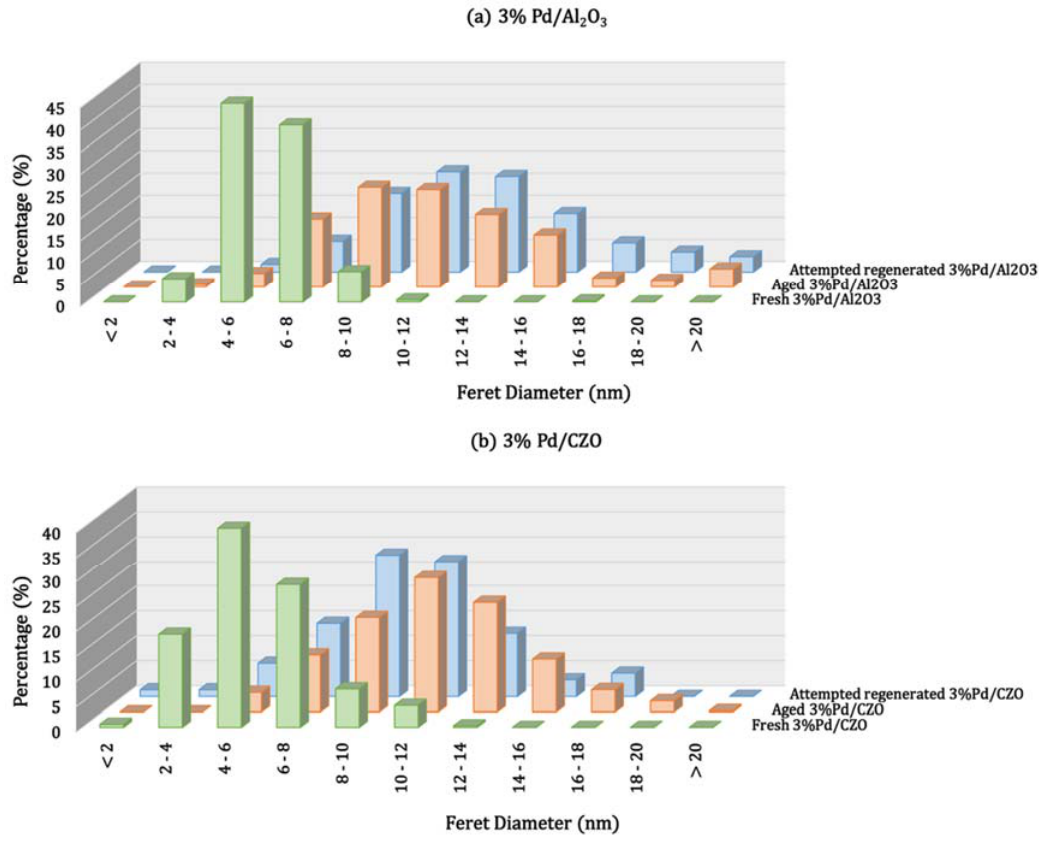
Figure 7. TEM-derived Pd metal particle size distributions of fresh, aged, and attempted regenerated ( a ) 3% Pd/Al 2 O 3 and ( b ) 3% Pd/CZO. Aging and attempted regeneration conditions were as described in Figure